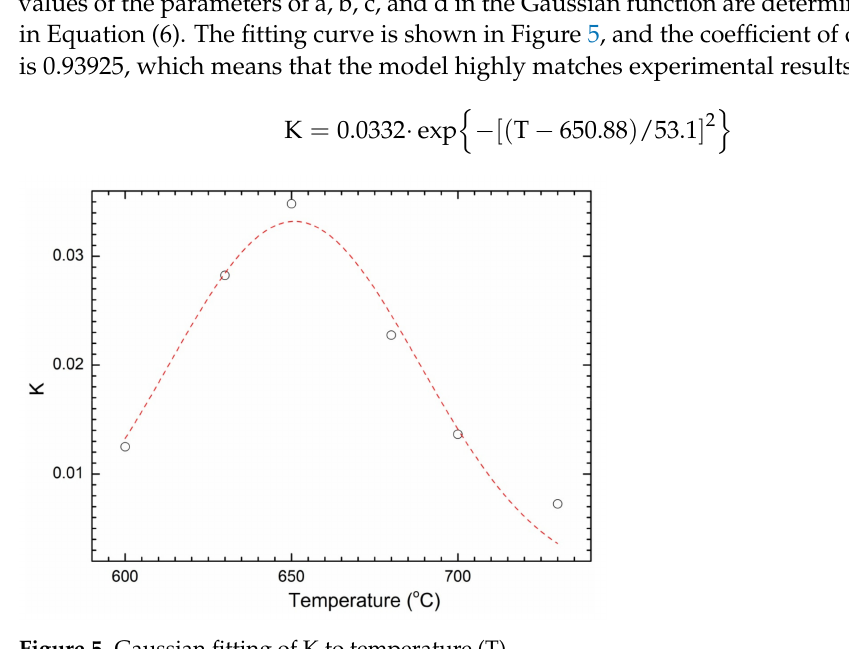
Figure 5. Gaussian fitting of K to temperature (T).